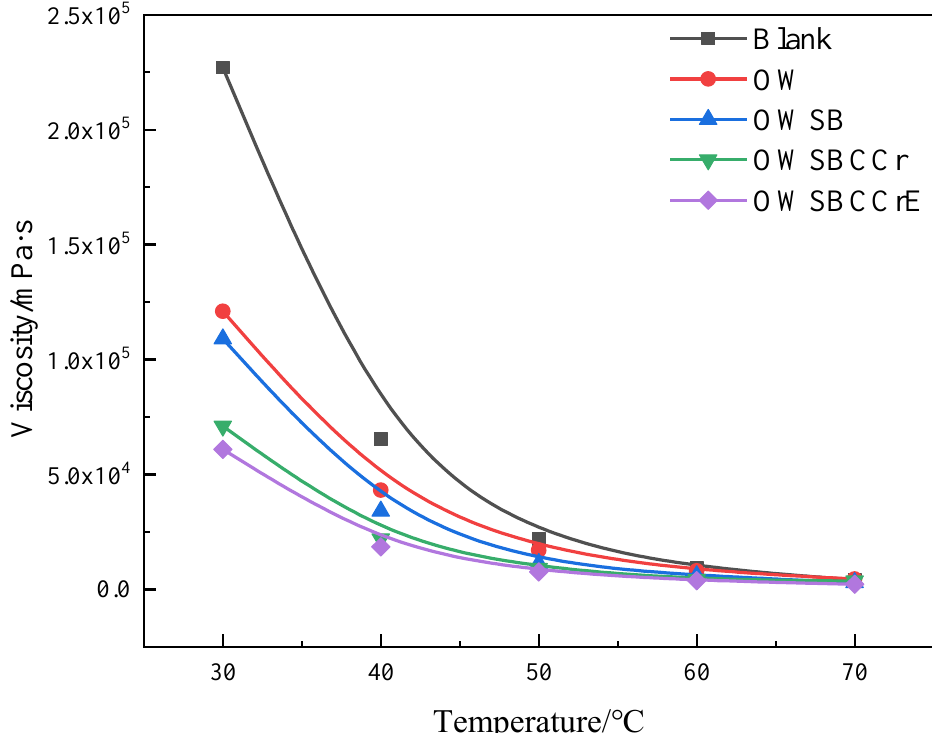
Figure 9. The viscosity of L8401 after reactions under different conditions.